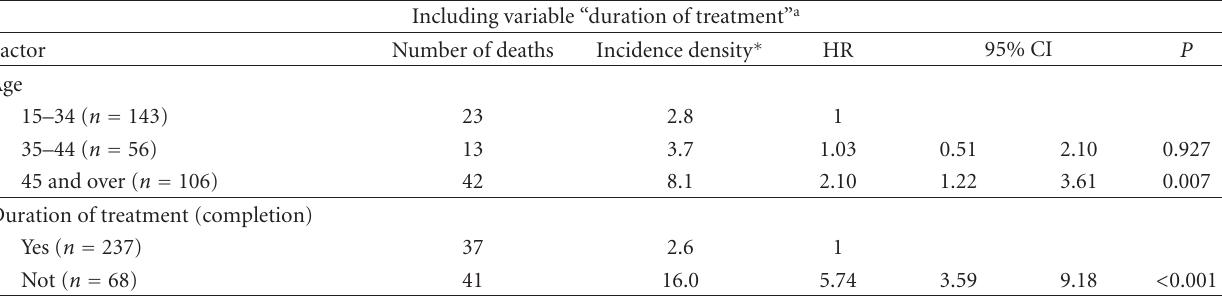
Table 2: Deaths, incidence density, and hazard ratios according cox regression models.